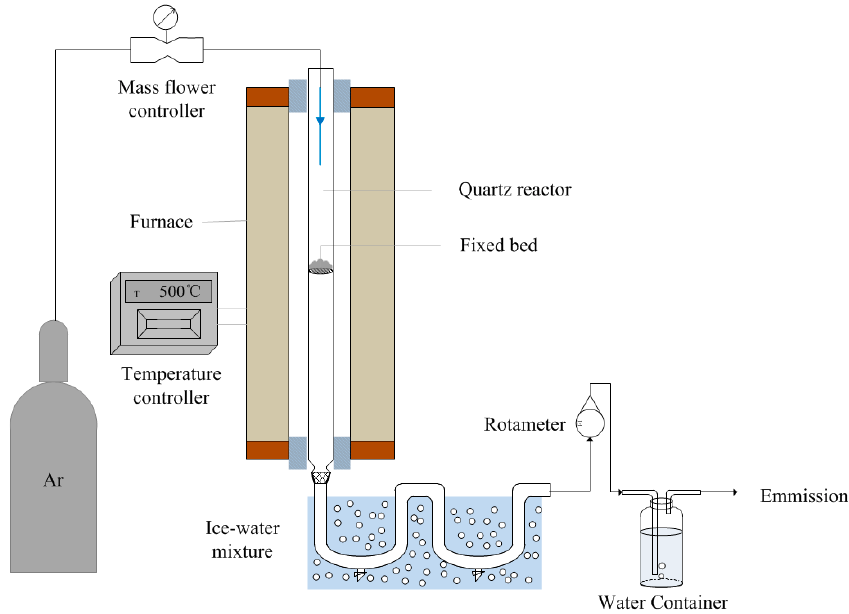
Figure 1. Schematic digram of the experimental set-up [3].